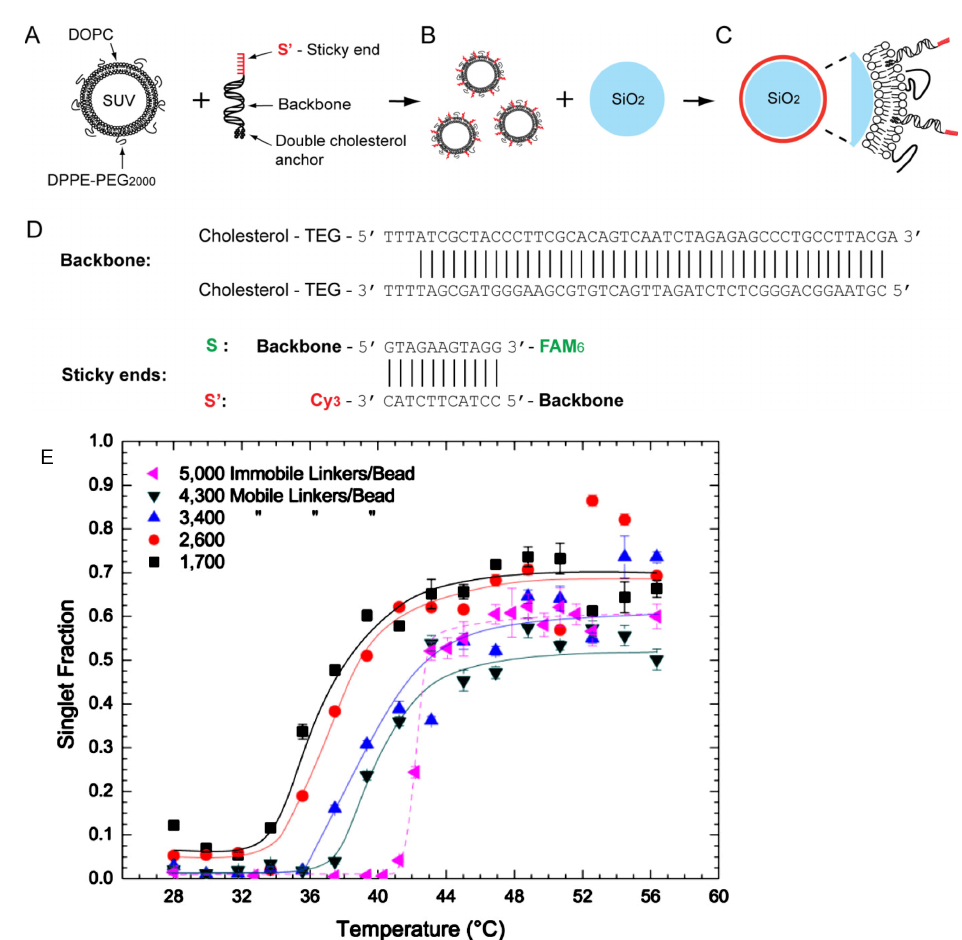
Figure 5. ( A – D ) represent the experimental scheme for creating particles grafted with mobile DNA strands. ( E ) shows temperature induced dissociation transition for different mobile-grafting den- sities and compares that with a system of particles grafted with immobile linkers. Reprinted with permission from [93]. Copyright 2013 American chemical